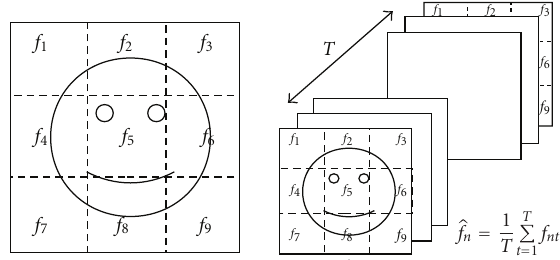
Figure 11: The feature vector of face